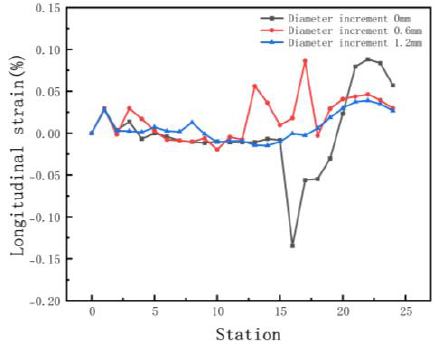
Figure 17. Longitudinal strain of strip in 3 diameter increments.